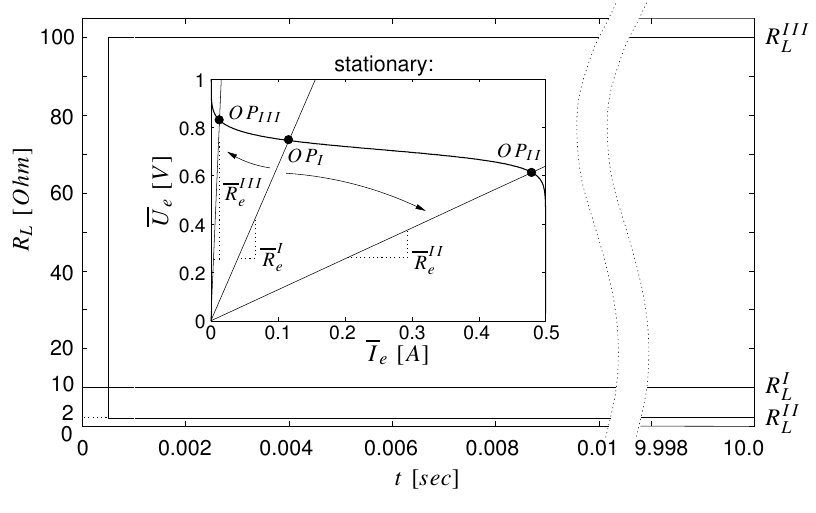
Figure 7. Time plot of load resistance R fuel cell with assigned operating